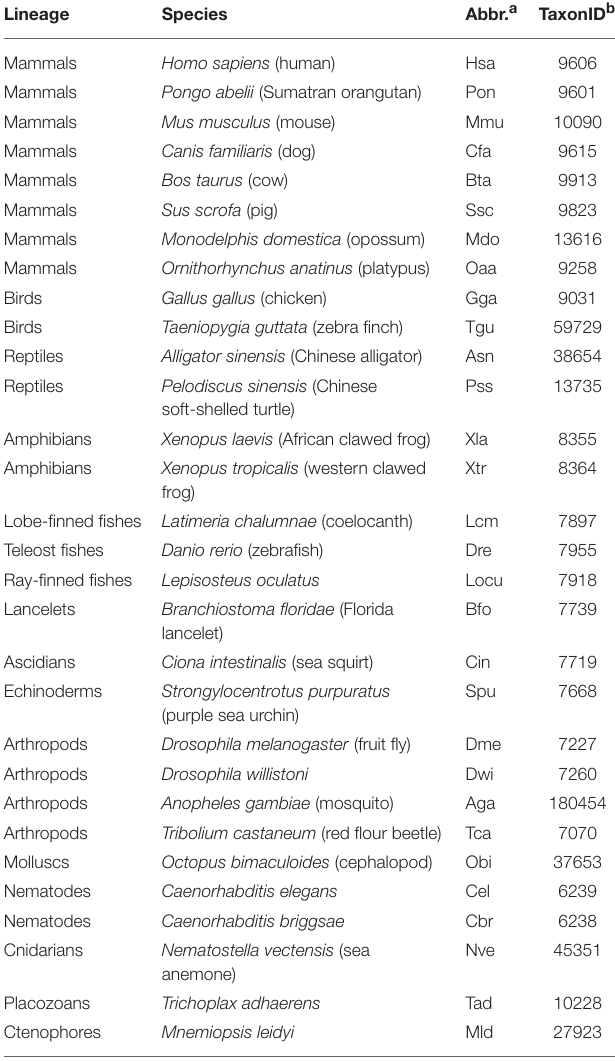
TABLE 1 | Representative metazoan species used in phylogenetic and molecular evolutionary